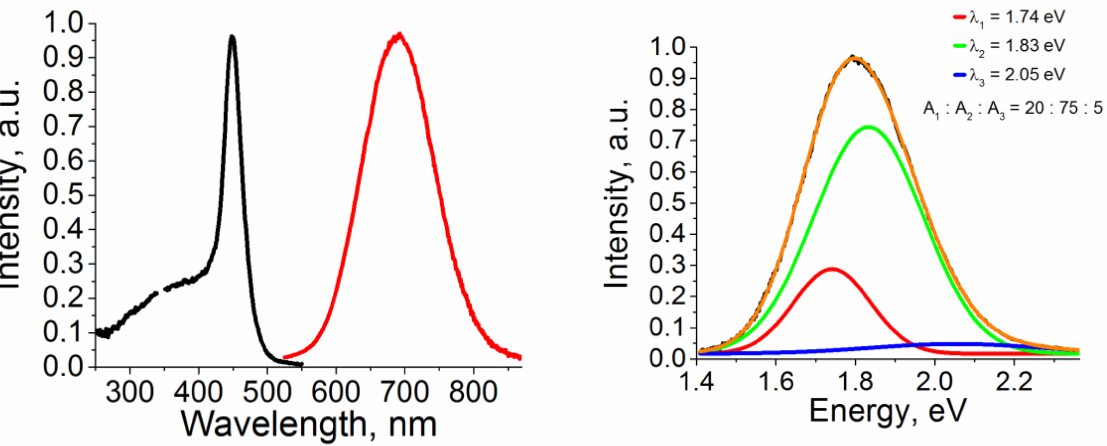
Figure 10. PLE spectrum (black curve, λ Em = 690 nm) and PL spectrum (red curve, λ Ex = 490 nm) of AgNO 3 /AgS t Bu reaction mixture in DMSO ( left ); PL spectrum ( λ Ex = 490 nm) of the reaction solution with three Gauss approximation ( λ 1 = 1.74 eV, λ 2 = 1.83 eV, λ 3 = 2.05 eV) ( right ). Table 1. The comparison between PL maxima of the reaction solutions and of solid 1 and 2 . Maxima